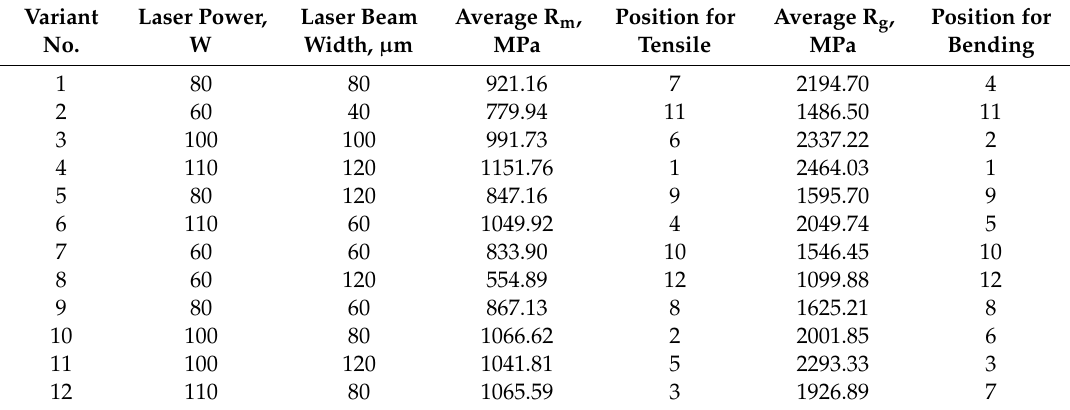
Figure 10. Relationship of bending strength ( a ) on the laser power for different widths of the laser beam ( b ) on the width of the laser beam for different values of the laser.